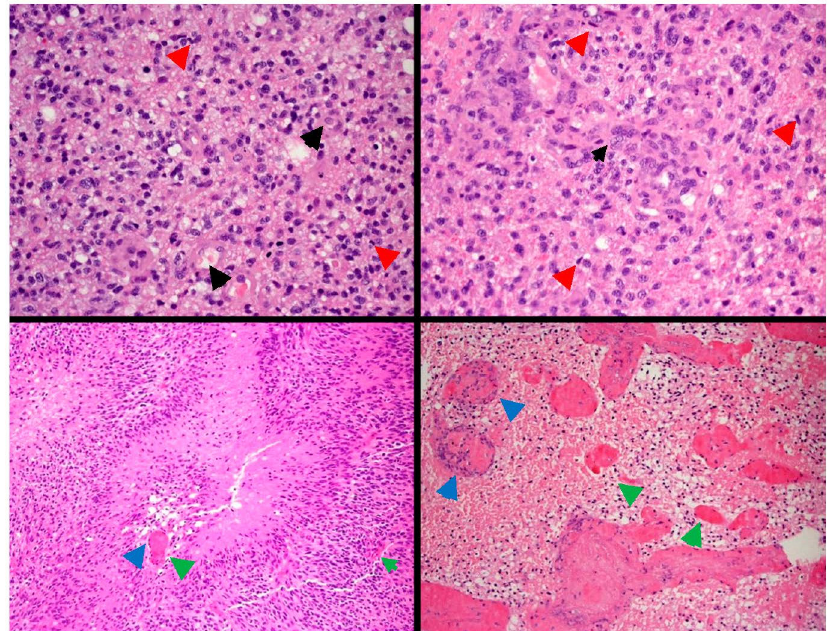
Figure 1. Glioblastoma with a poor prognosis based on its immunohistochemistry panel. Paraffin sections show fragments of a densely hypercellular glial tumor. The tumor is composed predominantly of moderately pleomorphic fibrillary astrocytes arranged in diffuse sheets. A small component of gemistocytic cells is noted (black arrows). There are moderate numbers of mitotic figures (red arrows). Foci of microvascular proliferation with multilayering of atypical cells around vessel lumena are also noted. Prominent pallisading and confluent necrosis is noted (blue arrows). Several of the latter areas incorporate thin-walled necrotic blood vessels (green arrows). The features are of glioblastoma multiforme (WHO Grade IV). GFAP: positive; Nestin; positive (high); IDH-1; R132H: negative (not mutated); ATRX: positive (not mutated); MGMT: negative (likely methylated); p53: positive p16; CDKN2A: negative; Topoisomerase labeling index: Approximately 35%. Case courtesy of RMH Neuropathology, Radiopaedia.org, rID 41309, modified.